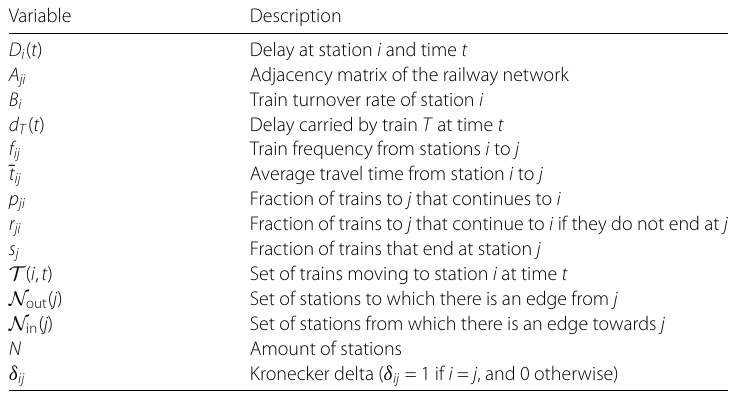
Table 1 Overview of the model variables and parameters